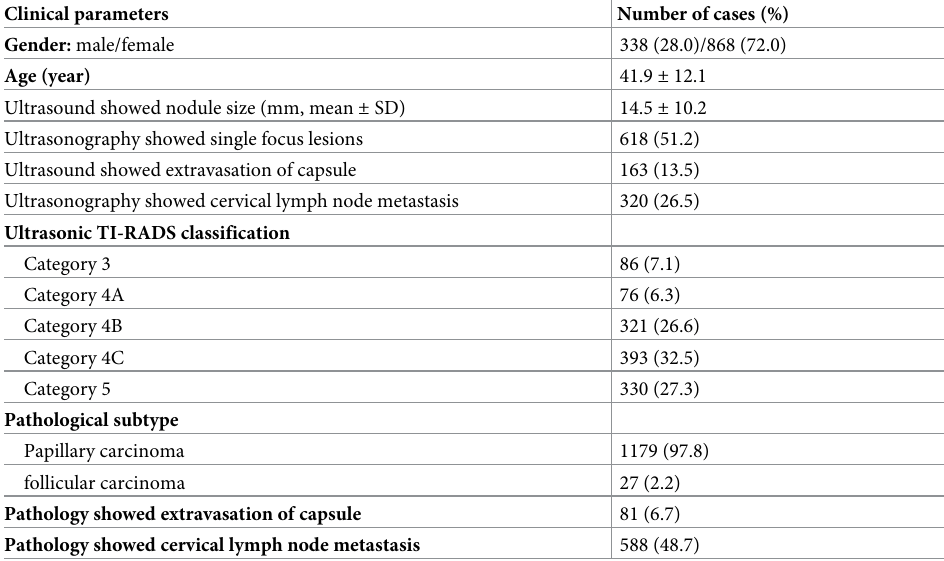
Table 3. Clinical parameters of DTC patients.